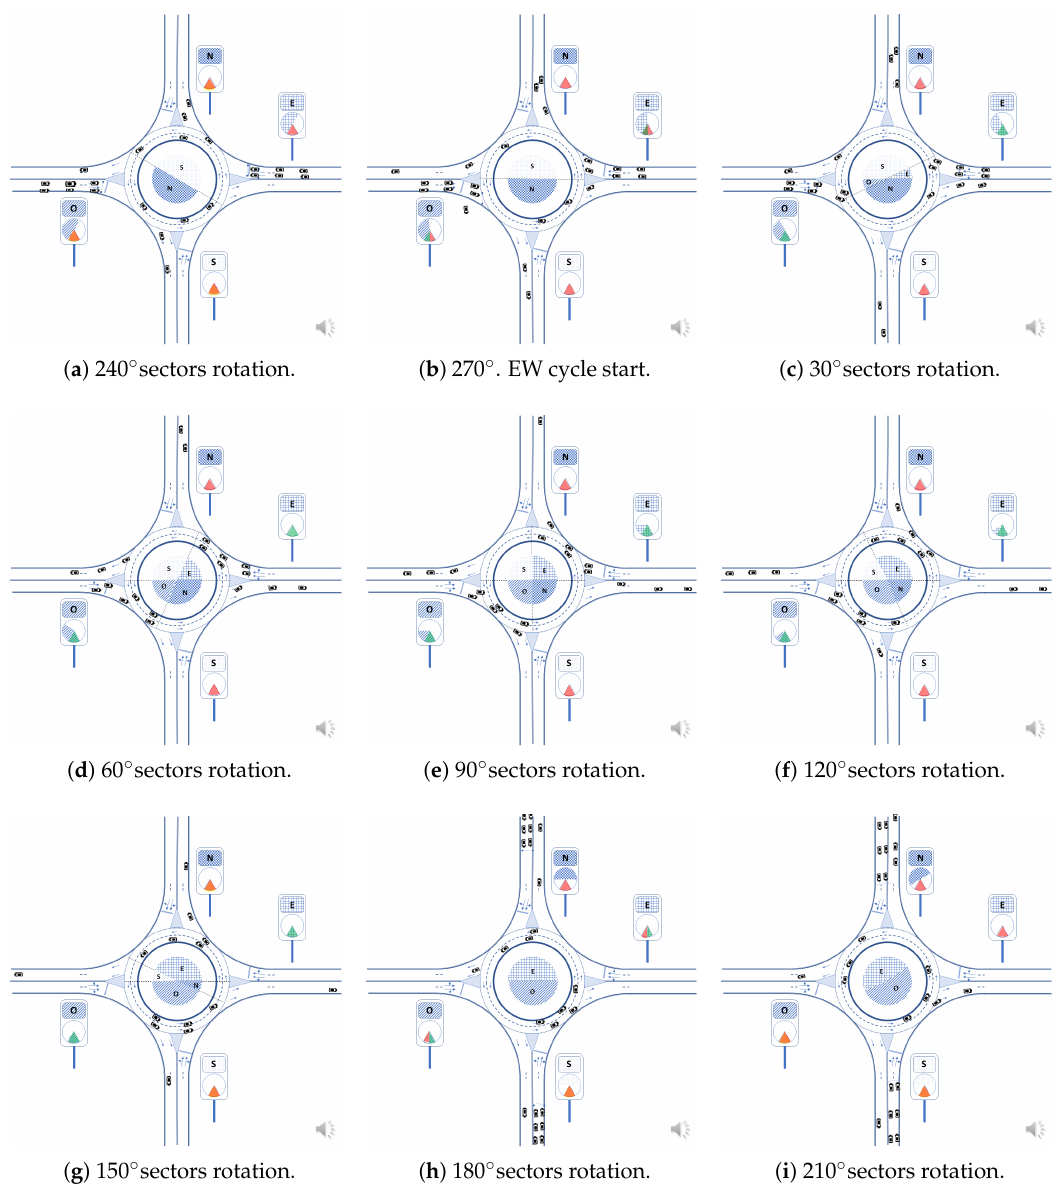
Figure 9. East-West (EW) access sequence. ( a , b ) show the completion of NS cycle. ( b ) shows the upcoming priority period for the east and west accesses. From ( b – h ), platoons at EW entries have priority. In ( i ) all entries are closed, and the roundabout